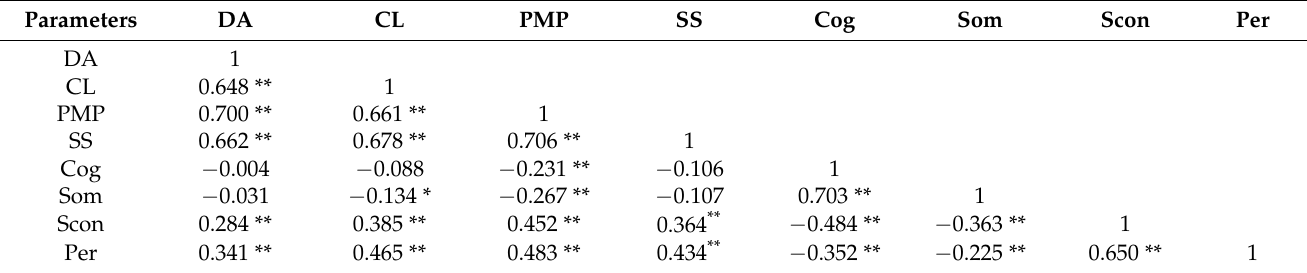
Table 5. Correlation analysis ( n = 215).